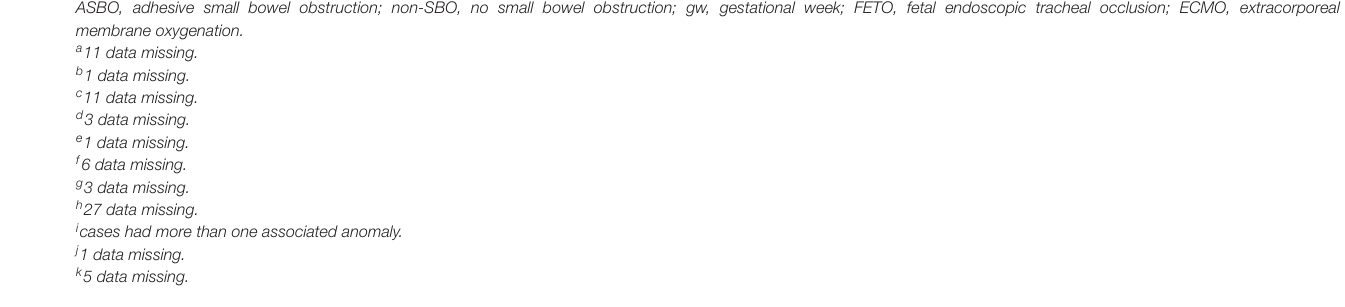
TABLE 5 | Differences in demographics, patient characteristics, and preoperative treatment between patients with ASBO- and non-SBO. Follow-up in years — median